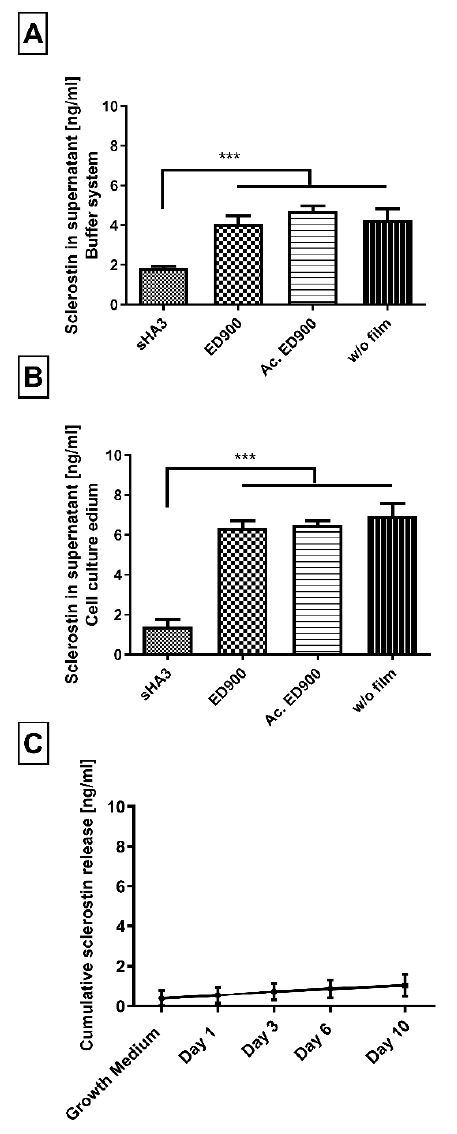
Figure 5. Sclerostin binding to variously decorated material films. ( A – C ) Di ff erently modified surfaces were incubated with 8 ng / mL sclerostin. Binding was quantified by the amount of unbound sclerostin in the supernatant after 24 h ( A , B ). ( C ) Cumulative sclerostin release from a saturated and preincubated (40 ng / mL) sHA3 surface. Sclerostin was presented in either 0.1% BSA and 0.2% Tween 80 in PBS ( A ) or DMEM with 10% serum ( B , C ). Film surfaces: sHA3: covalent ED900 and sHA3-coating; ED900: neutralize positive charge; T134LA6: nonmodified film. All values represent the mean ± SD of n ≥ 4. *** p < 0.001 denotes significant di ff erence vs. the respective surface